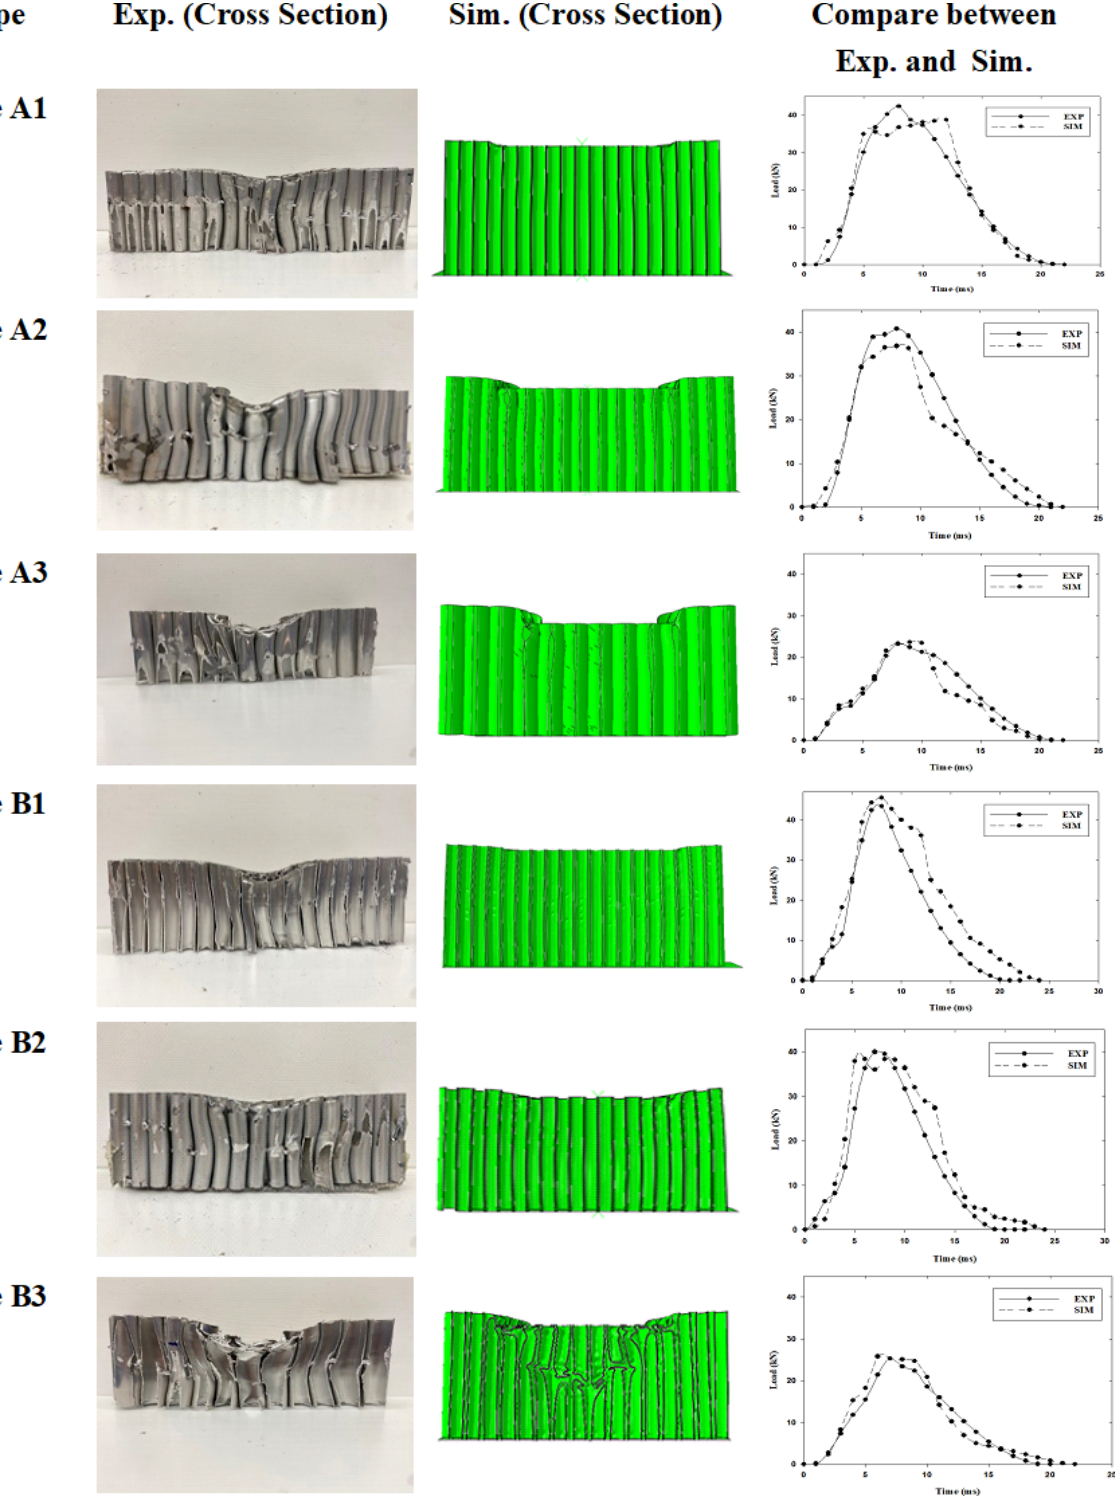
Figure 7: Crashworthiness patterns of circular aluminum honeycomb Type A and Type B at 4 m height by comparison of experimental and FEA simulation